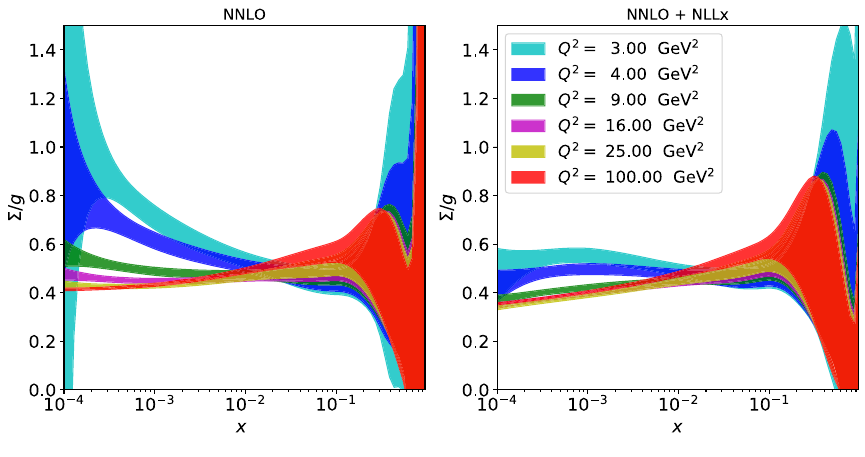
Fig. 6 The resummed splitting functions at NNLO+NLL x (solid) compared to fixed order at LO (dotted), NLO (dashed) and NNLO (dot- dot-dashed) for P gg (upper curves) and P qg (lower curves) as a function of x . The plots are at α S ( Q 2 ) = 0 . 28 (corresponding to Q 2 ∼ 4GeV 2 ) and n f = 4